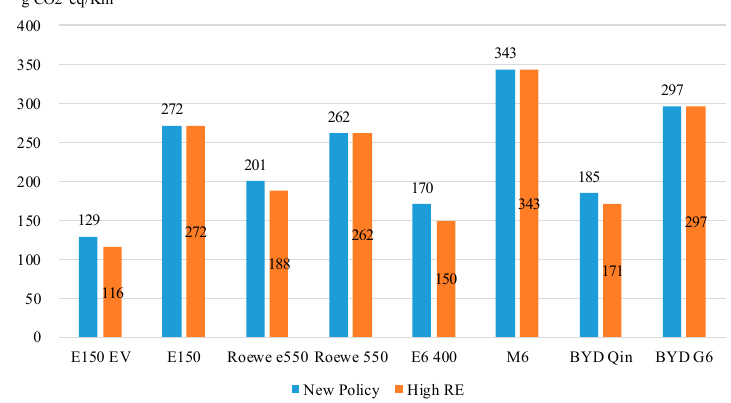
Figure 6. GHG emissions per km from selected vehicles.